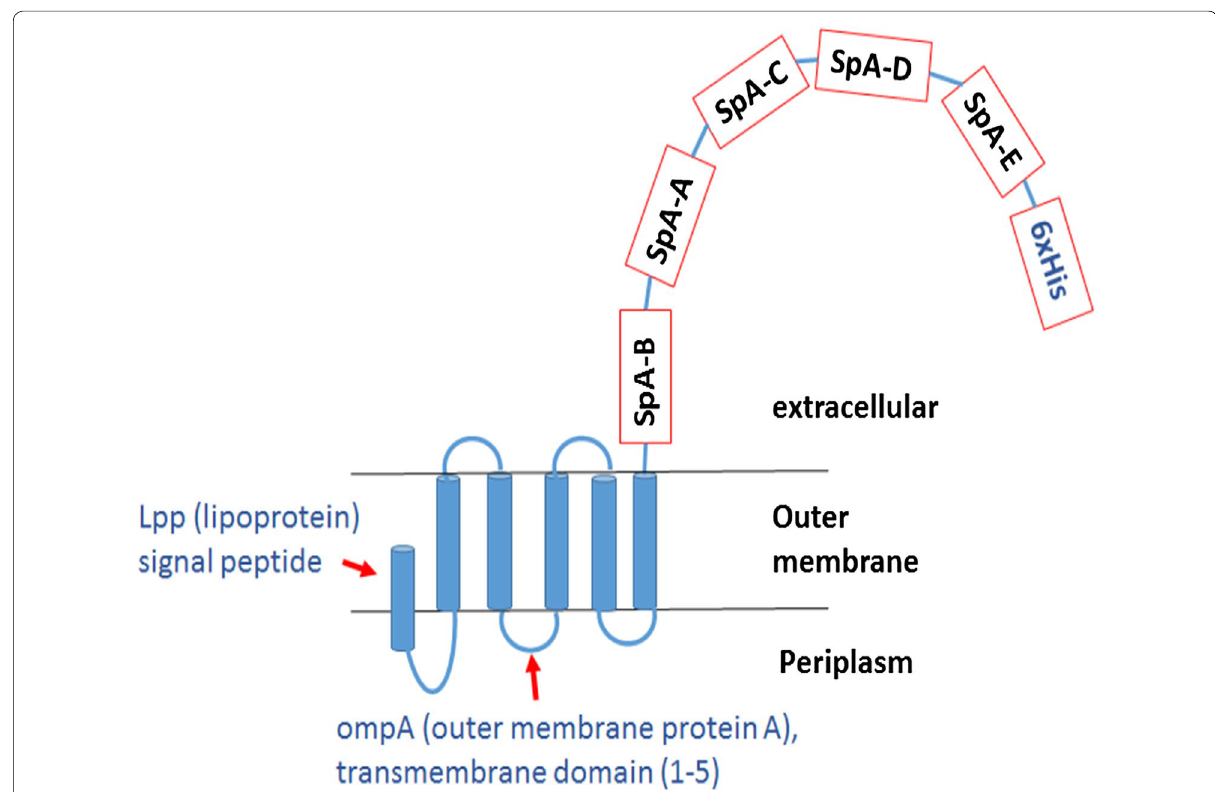
Fig. 1 Schematic illustration of Lpp ′ -OmpA, SpA 295